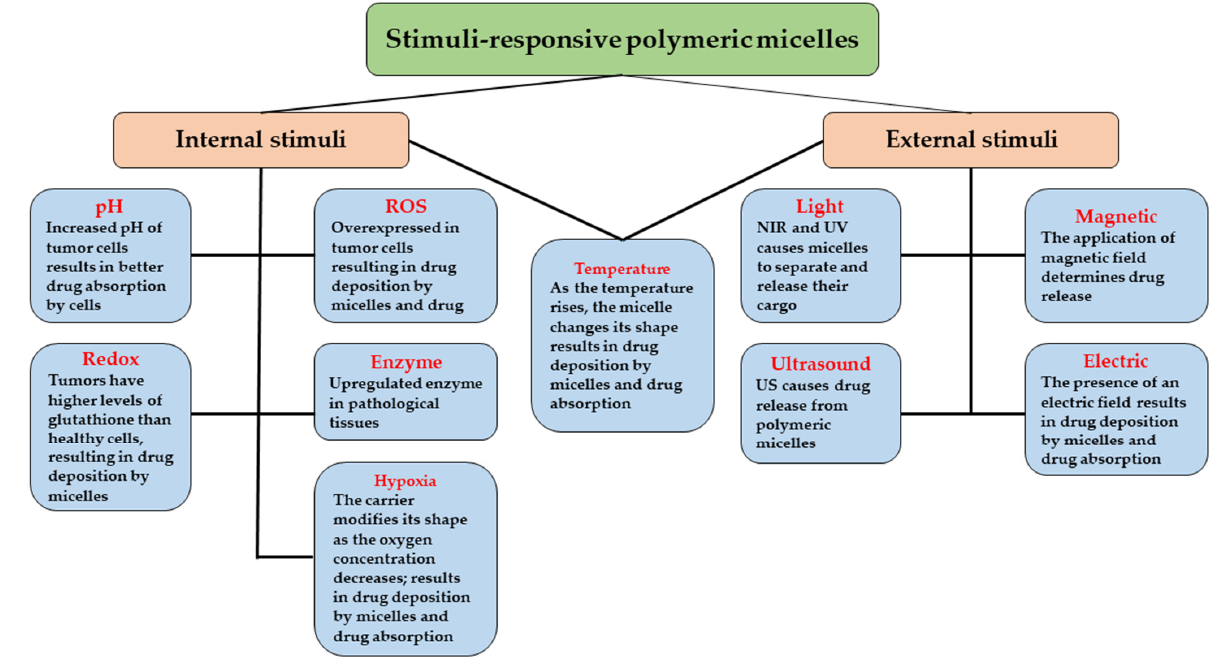
Figure 6. Classification of stimuli ‐ sensitive polymeric micelles.